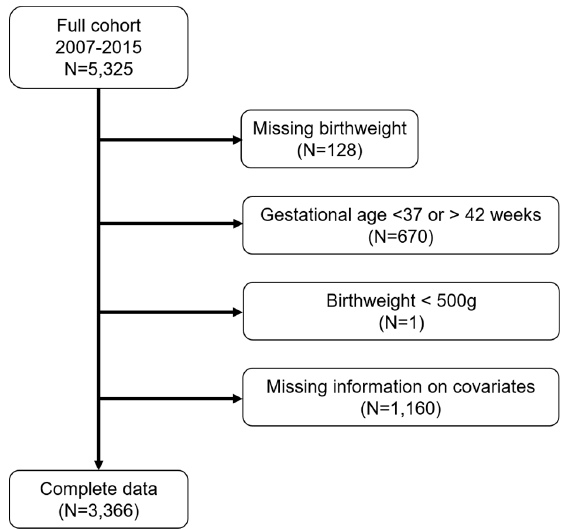
Figure 1. Number of Boston-based Children’s HealthWatch study subjects excluded from the final analytical sample .